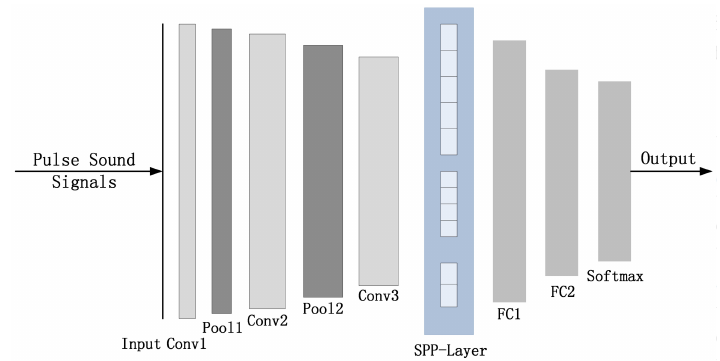
Figure 4. The Structure of the Monitoring Network.